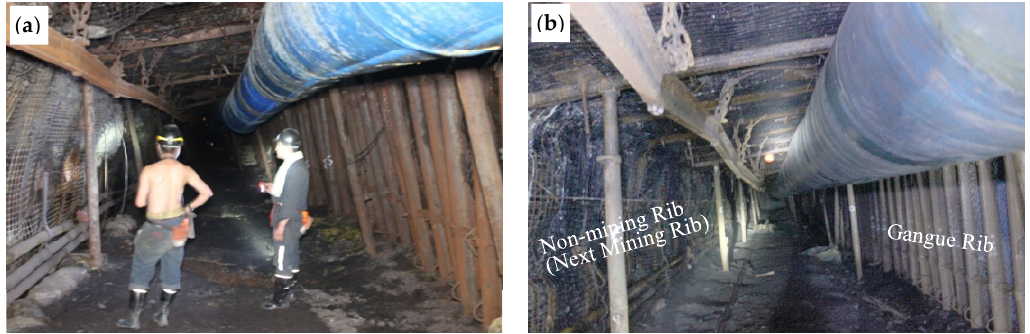
Figure 21. GERRC effect: ( a ) 50 m from open-off cut; ( b ) 200 m from open-off cut.